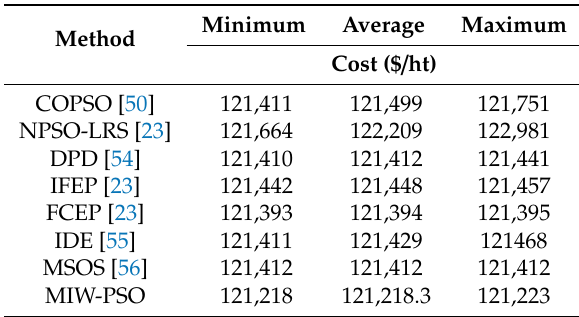
Table 12. Total generation cost comparison on the fourth case study.